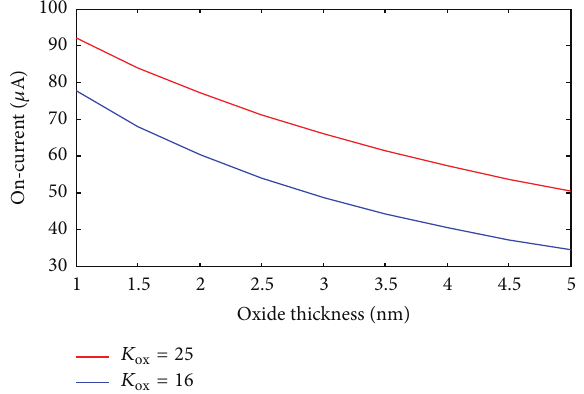
Figure 17: The on-current with different oxide thickness.